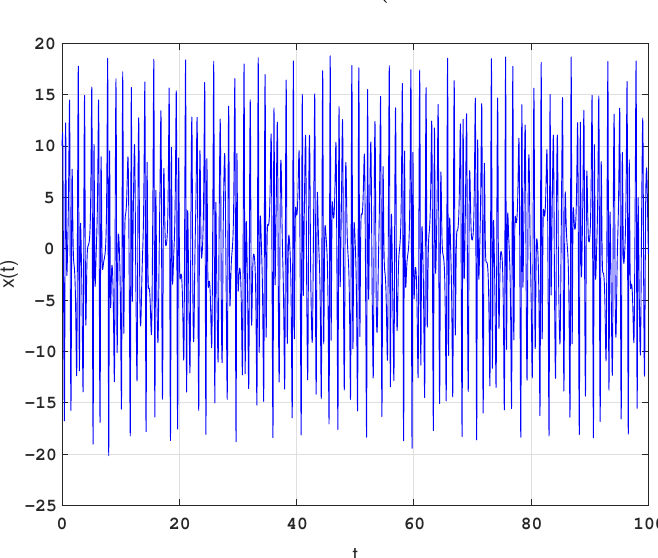
Figure 6. Time diagram of state variable x with the initial condition x ( 0 ) = [ 5, − 2,3, − 3 ] T